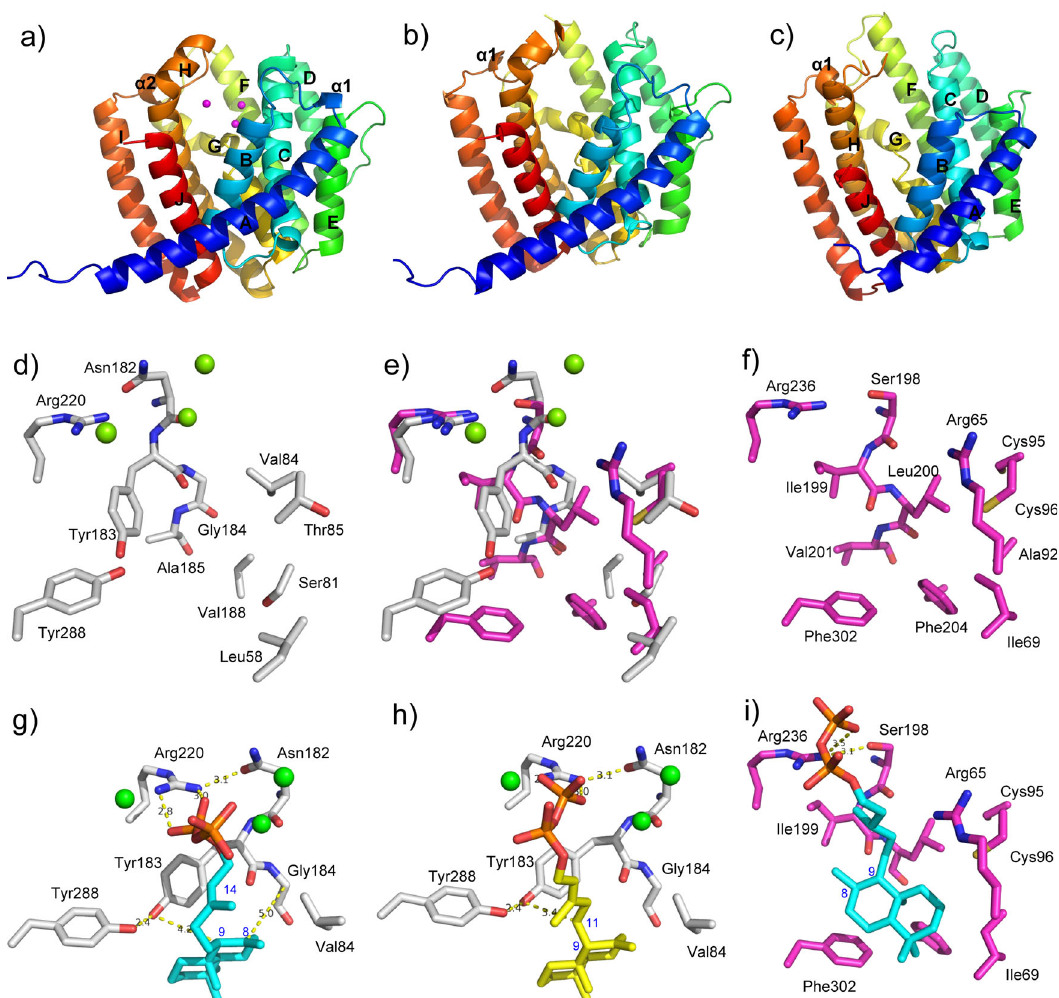
Fig. 3 The crystal structures and active sites of Sat1646-Mg 2 + , Sat1646, and Stt4548, and substrates modeling. a The crystal structure of Sat1646-Mg 2 + (Mg 2 + ions in magenta spheres). b The crystal structure of Sat1646. c The crystal structure of Stt4548. d The active site of Sat1646-Mg 2 + . e The superimposition of active sites of Sat1646-Mg 2 + and Stt4548. f The active site of Stt4548. g The modeling of CPP (cyan sticks) into the active site of Sat1646-Mg 2 + . h The modeling of syn -CPP (yellow sticks) into the active site of Sat1646-Mg 2 + . i The modeling of CPP (cyan sticks) into the active site of Stt4548. The structures in a – c are shown with coloring from blue on the N-terminus to red on the C-terminus. In d – i , the residues and Mg 2 + ions of Sat1646-Mg 2 + are shown in gray sticks and green spheres, respectively, and the residues of Stt4548 are shown in magenta